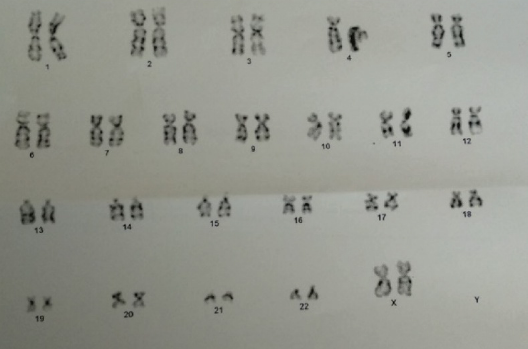
omentumFigure 2B: Karyotping showing 46 XX